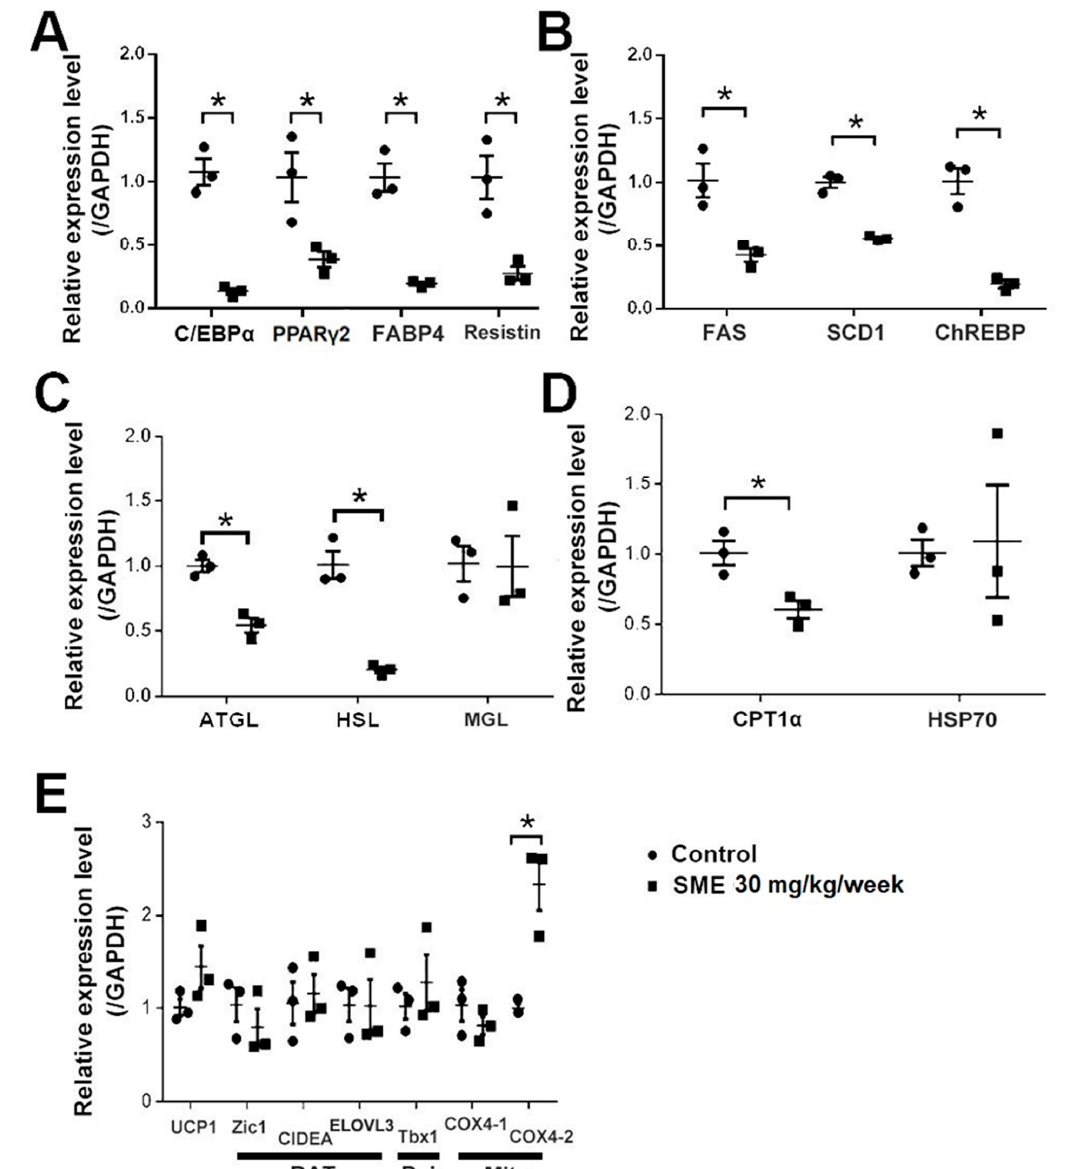
Figure 2. SME treatment ameliorates adipogenesis/lipolysis imbalance in HFD-fed mice. Effects of SME treatment on WT mice after 5 weeks of an HFD were analyzed. Expression of ( A ) adipogenic, ( B ) lipogenic, ( C ) lipolytic, ( D ) β -oxidation, and ( E ) brown (BAT), beige (Bei), and mitochondria (Mito) genes in inguinal WAT. Data are the mean ± SEM. ( n = 3 per group); * p < 0.05 compared with